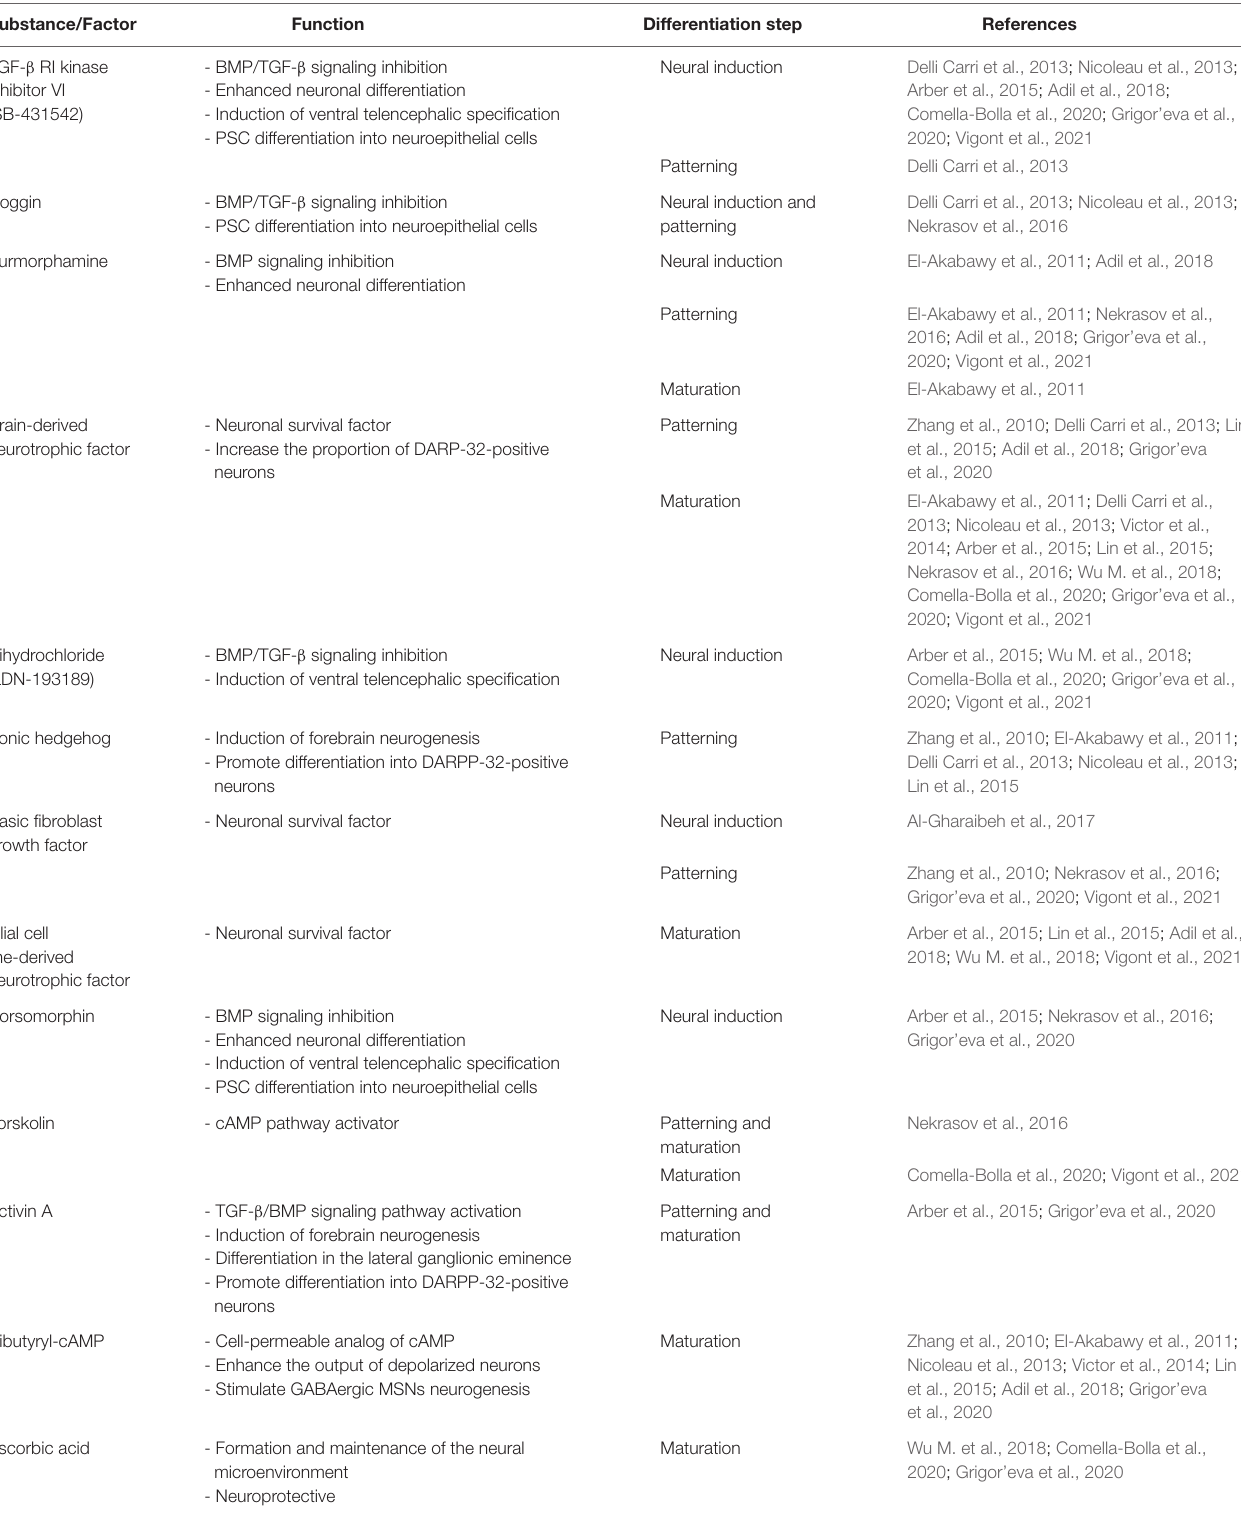
TABLE 2 | Small molecules, inhibitor, transcription factors, and growth factors used for iPSC, ECS, and NPC differentiation and